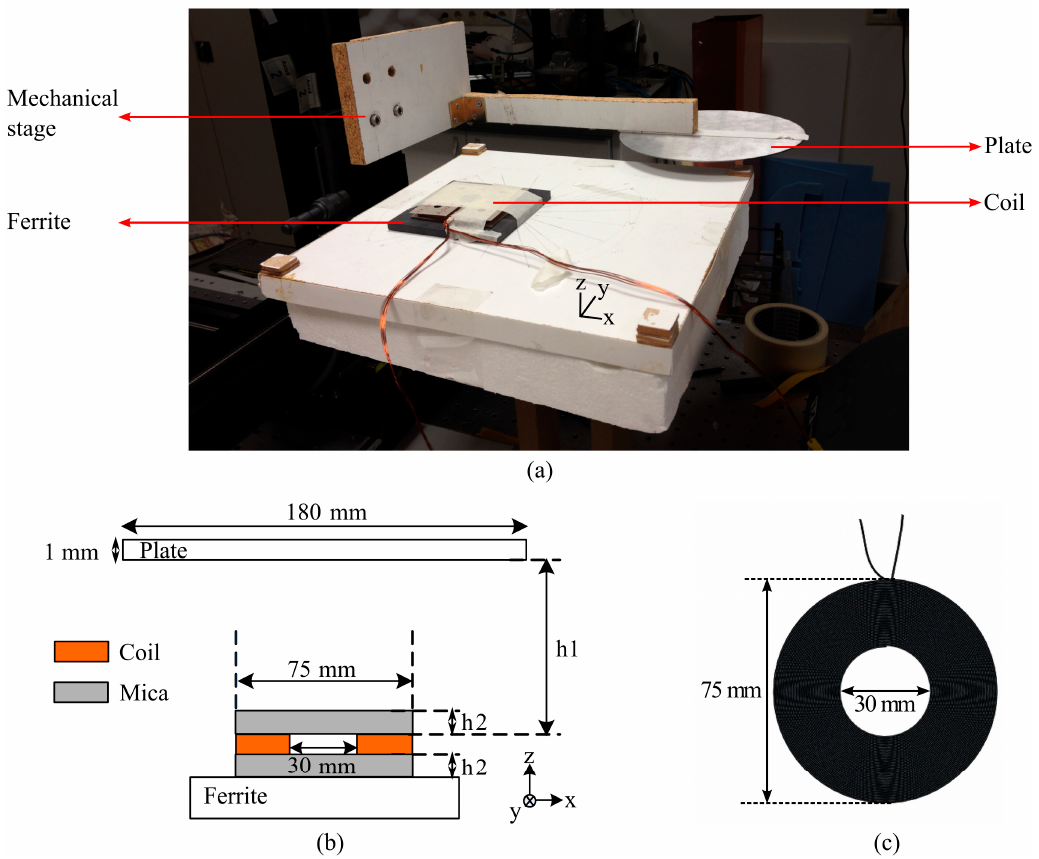
Figure 2. ( a ) measurement setup and its parts, where components are pointed out and indicated with red arrows; ( b ) coupled system from side-view together with its geometrical parameters; and ( c ) the coil structure used in measurements and its geometrical sizes.